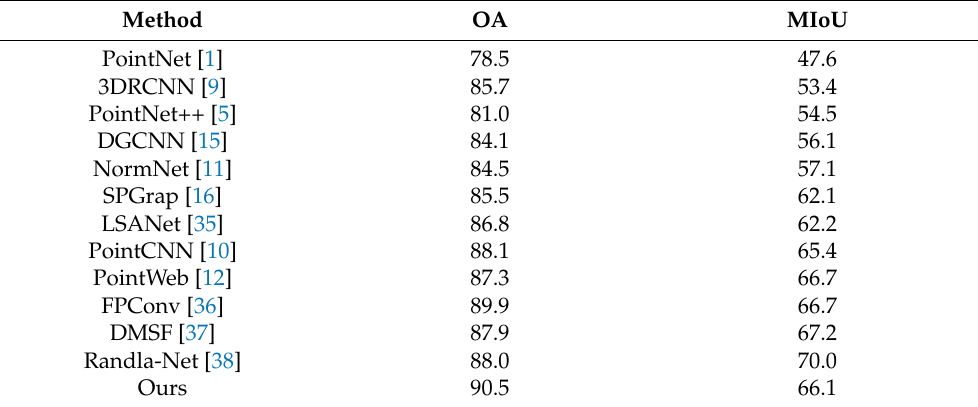
Table 6. Semantic segmentation accuracy on S3DIS